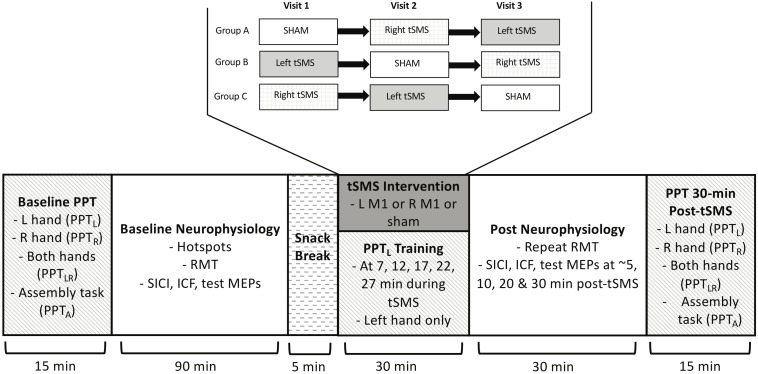
PSTIM protocol. Participants completed baseline PPT (all tasks: PPTL, PPTR, PPTLR, PPTA), and then underwent baseline neurophysiology testing, including determining the “hotspot”, identifying the RMT, and performing single and paired pulse protocols for test MEPs, SICI and ICF. They then received the tSMS intervention paired with motor training on the PPTL. There were 3 treatment orders, as shown. Neurophysiology measures (single and paired pulse) and PPT (all tasks) were repeated at multiple time intervals post-tSMS.